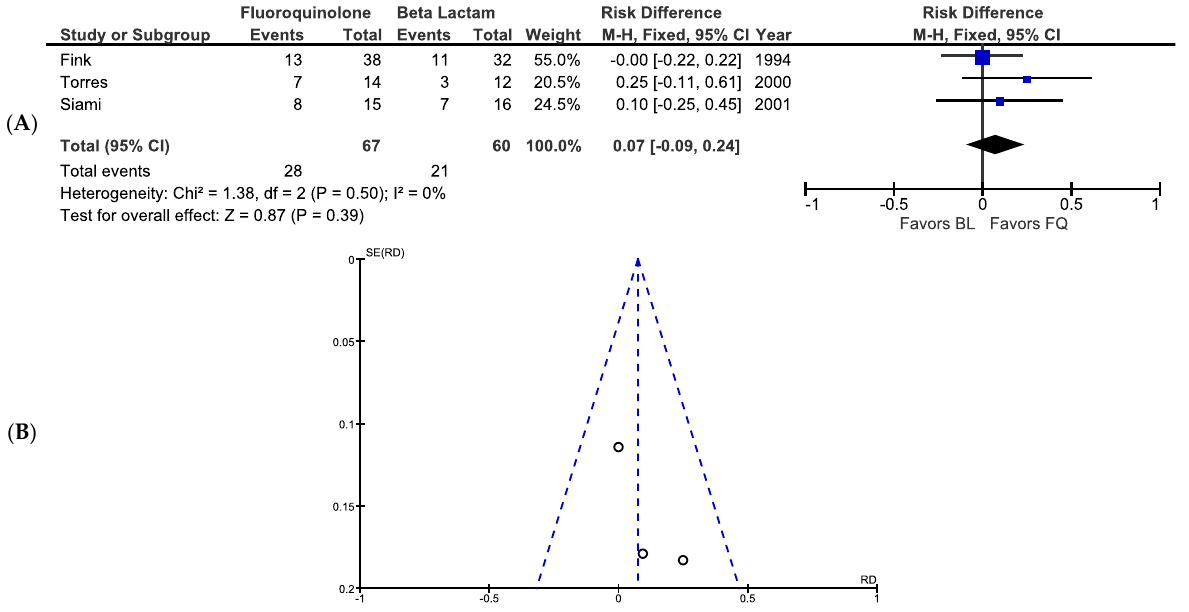
Figure 3. ( A ) Forest plot showing FQ monotherapy is associated with similar bacteriological eradication compared to BL monotherapy using a fixed-effects model. ( B ) Funnel plot showing the studies included in the meta-analysis.